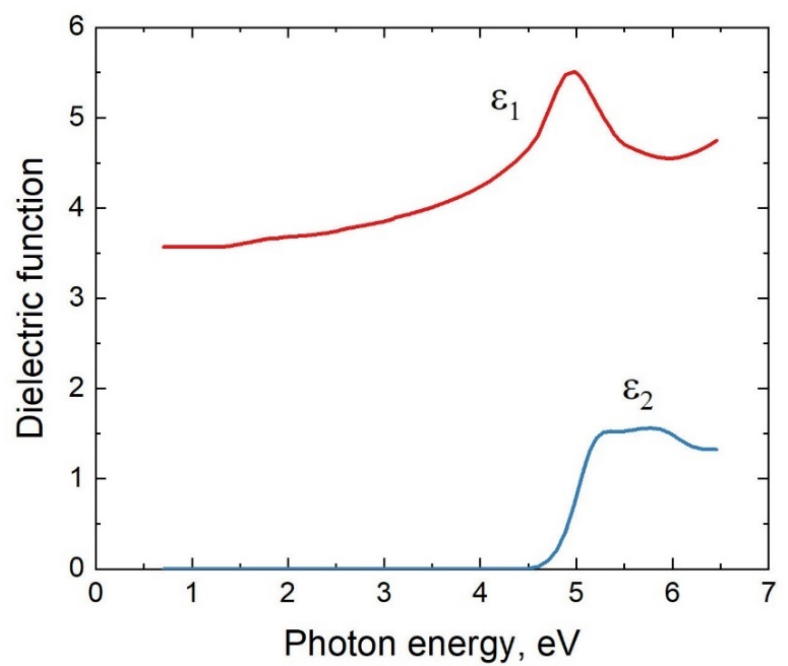
Figure 7. Dependence of the ordinary dielectric function of β -Ga 2 O 3 on the photon energy. ε 1 is the real part of the dielectric function; ε 2 is its imaginary